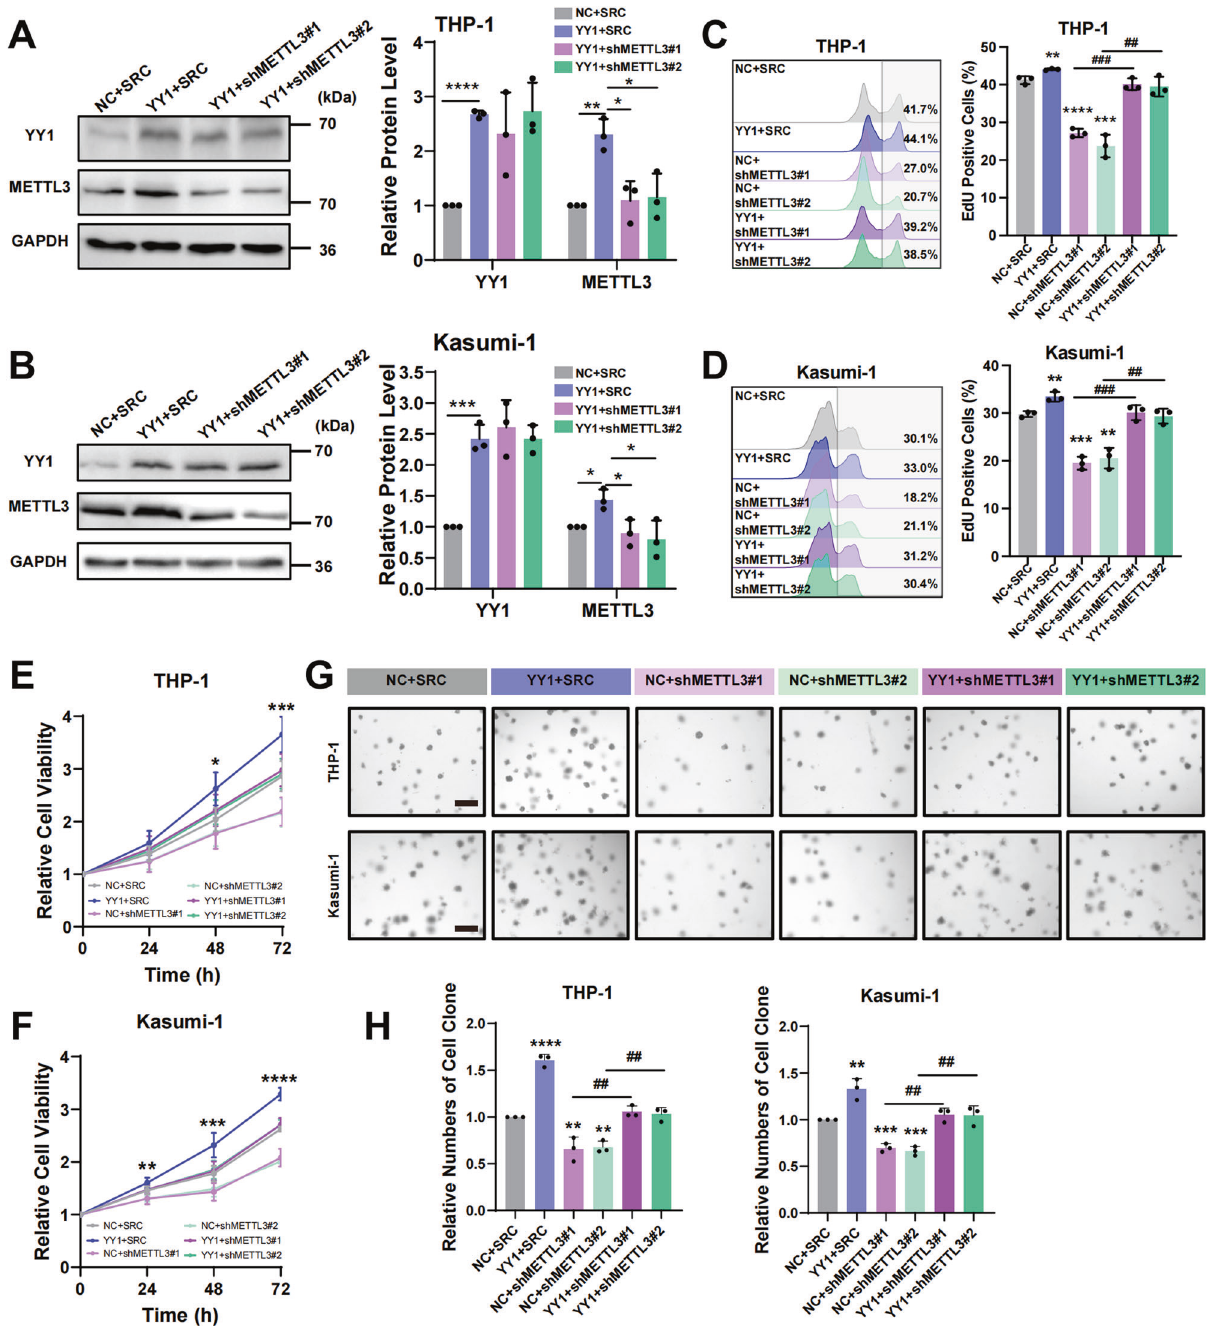
Fig. 2 YY1 enhances AML cell proliferation in a METTL3-dependent manner. A , B Western blotting analysis of YY1 and METTL3 expression at protein level in YY1 OE or NC THP-1 ( A ) and Kasumi-1 ( B ) cells transfected with METTL3 interfering virus or scramble virus. * P < 0.05; ** P < 0.01; *** P < 0.001; **** P < 0.0001, t -test. C , D The proliferative activity of THP-1 ( C ) and Kasumi-1 ( D ) cells measured by fl ow cytometry EdU assay. *Compare to the NC + SRC group. ** P < 0.01; *** P < 0.001; *** P < 0.0001; ## P < 0.01; ### P < 0.001, t -test. E , F The proliferative activity of THP-1 ( E ) and Kasumi-1 ( F ) cells measured by CCK-8 assay. * P < 0.05; ** P < 0.01; *** P < 0.001; **** P < 0.0001, one-way ANOVA. G The number of cell clone formed assessed by colony formation assay. Scale bars, 500 μ m. H Statistical chart of colony formation experiment. *Compare to the NC + SRC group. ** P < 0.01; *** P < 0.001; *** P < 0.0001; ## P < 0.01, t Using PCR and western blotting, we found that CHI could and detected its acetylation levels by pan-acetylated antibody. signi fi cantly reduce the expression of METTL3 in THP-1 and The results showed that the acetylation levels of YY1 was Kasumi-1 cells and could reverse the increase in METTL3 increased signi fi cantly when the cells were treated by HDAC expression caused by YY1 overexpression (Fig. 3F, G). All these inhibitor (Fig. 3E). To further assess the role of HDACs in the results suggested that CHI regulates YY1 and inhibits its transcriptional regulation of METTL3 by YY1, THP-1, and Kasumi- transcriptional regulation of METTL3. 1 cells were treated with CHI, while DMSO was used as a control.